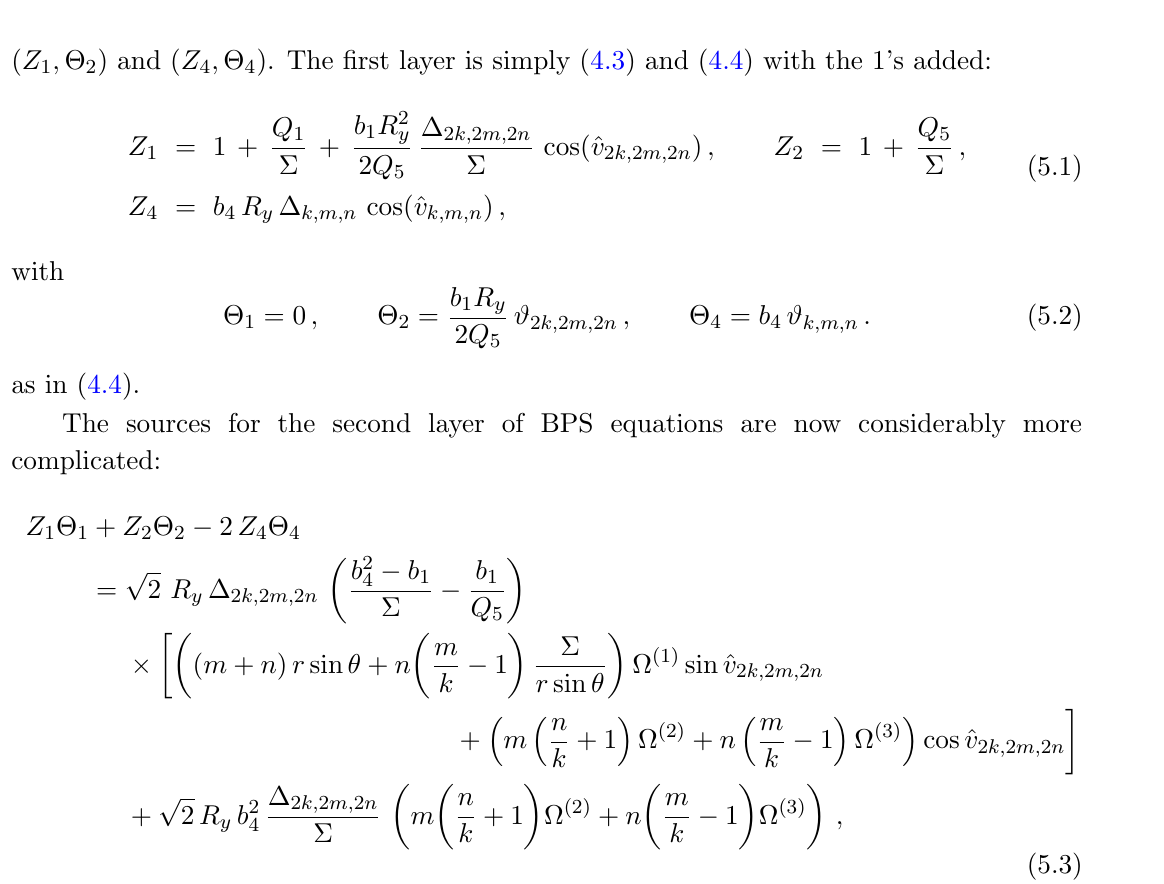
p p p Q 1 = Q 5 = 10 5 , R y = 10 7 , so that b ’ 2 (cid:2) 10 3